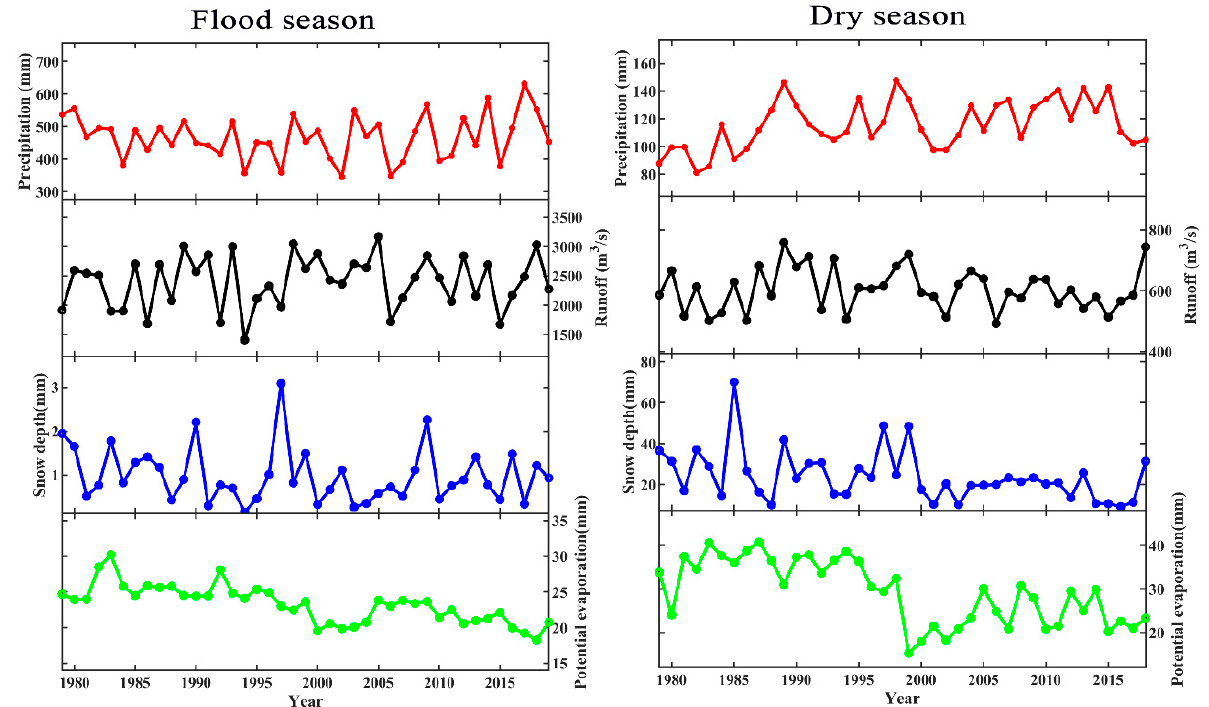
Figure 3. Interannual characteristics of water resources in the upper reaches of Jinsha River.